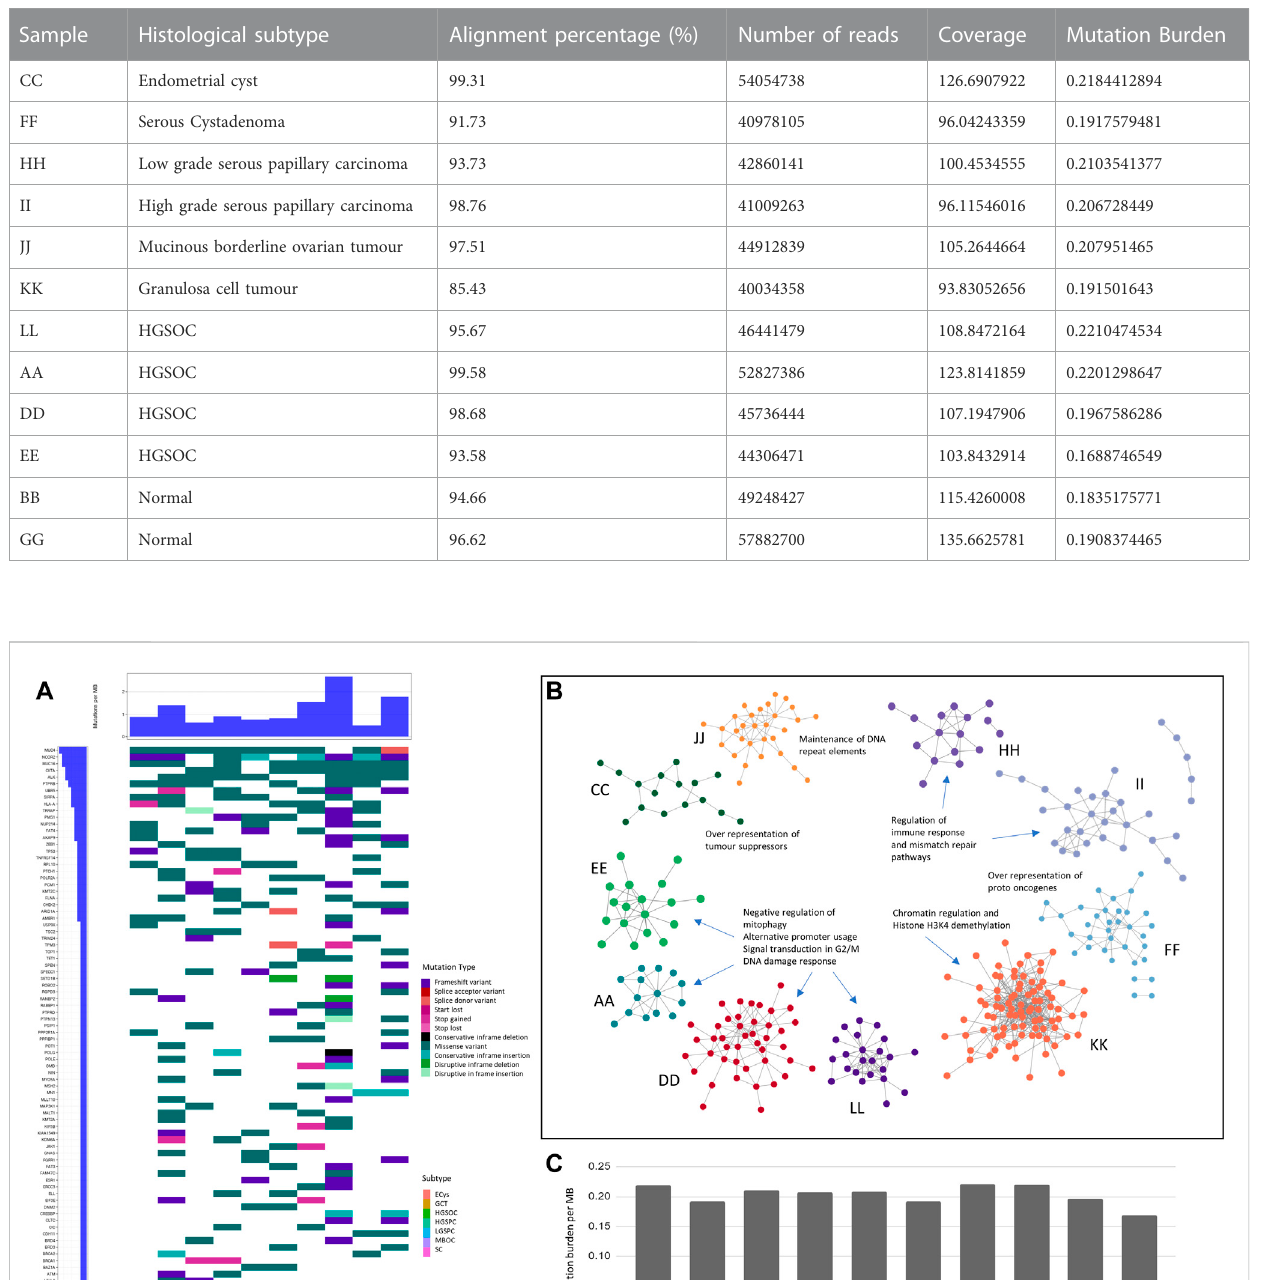
TABLE 2 Exome sample details.